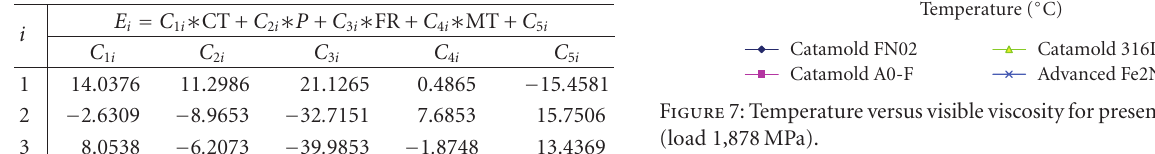
Table 5: The weights between input layer and hidden layer for Fe − 2Ni.